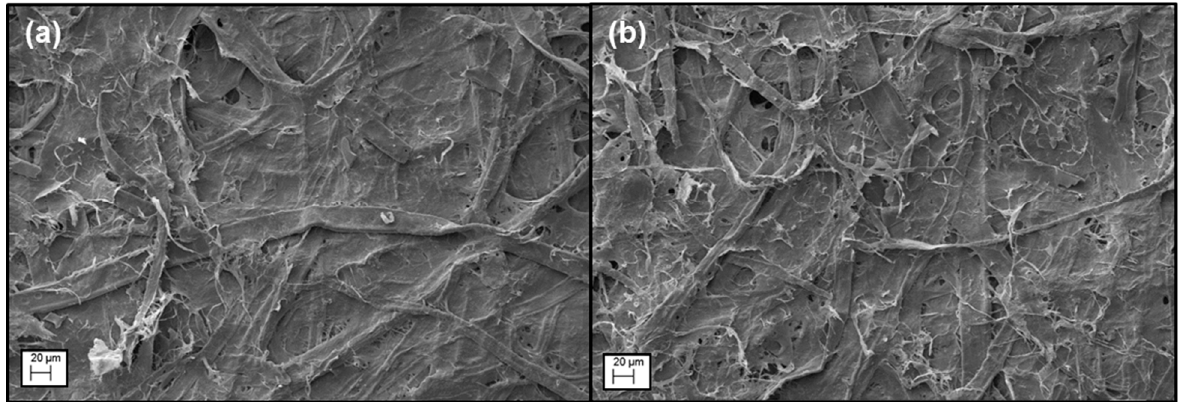
Figure 4. SEM images of recycled fiber paper reinforced by ( a ) undispersed BC and ( b ) glucomannan dispersed BC.